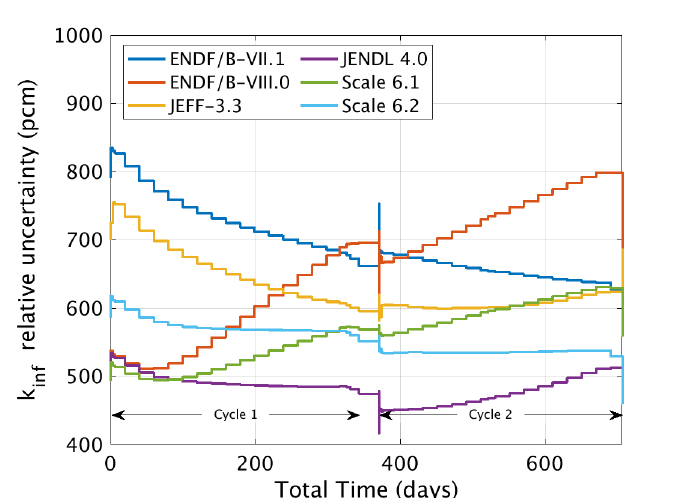
Figure 1: Evolution of the k relative standard deviation with exposure. Various inf covariance matrices are